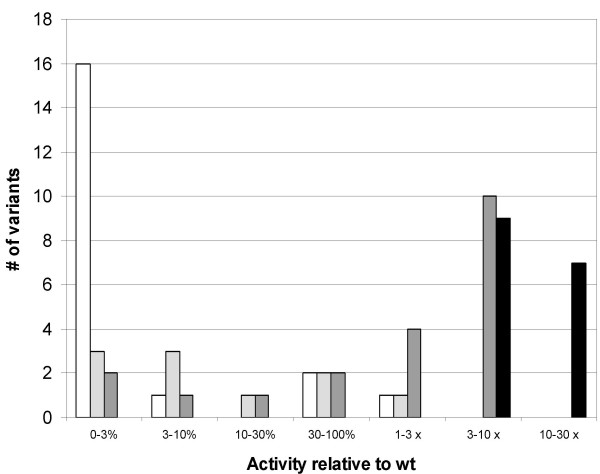
Machine learning design compared with random choices and "expert" designs. Distribution of activities of 4 sets of variants designed using different methods are shown. Set A (white bars, variants 1–2, 1–6, 1–12, 1–13 and 1–34 to 1–49, total of 20 variants) contain arbitrarily selected combinations of 3, 5 or 6 substitutions. Set B (light shading, variants 1–50 to 1–59, total of 10 variants) were designed by manual analysis of the sequence and activity data from variants 1 through 49. Set C (dark shading, variants 2-1 to 2–20, total of 20 variants) were designed using machine learning algorithms based on the data from variants 1 through 59. Set D (black fill, variants 3-1 to 3–16, total of 16 variants) were designed using machine learning algorithms based on the data from variants 1-1 through 1–59 and 2-1 through 2–20.